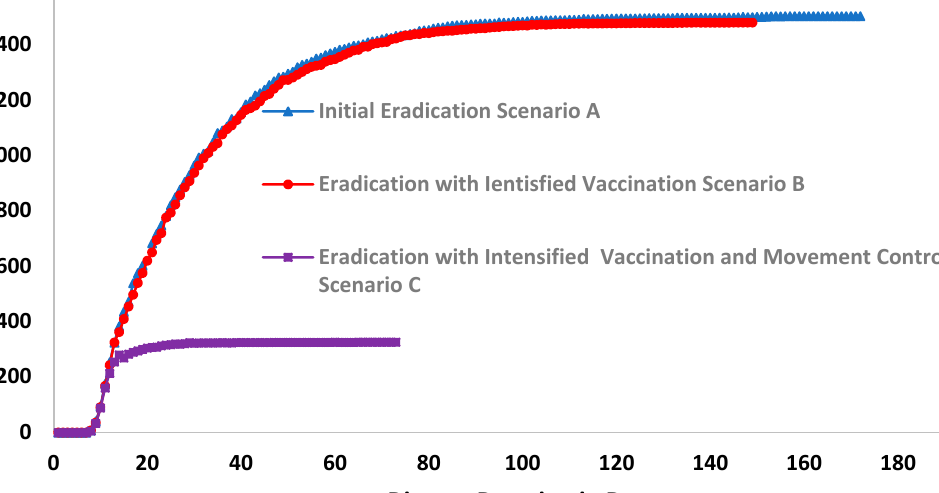
Figure 6. Absolute number of infected animals and outbreak duration in the three scenarios.